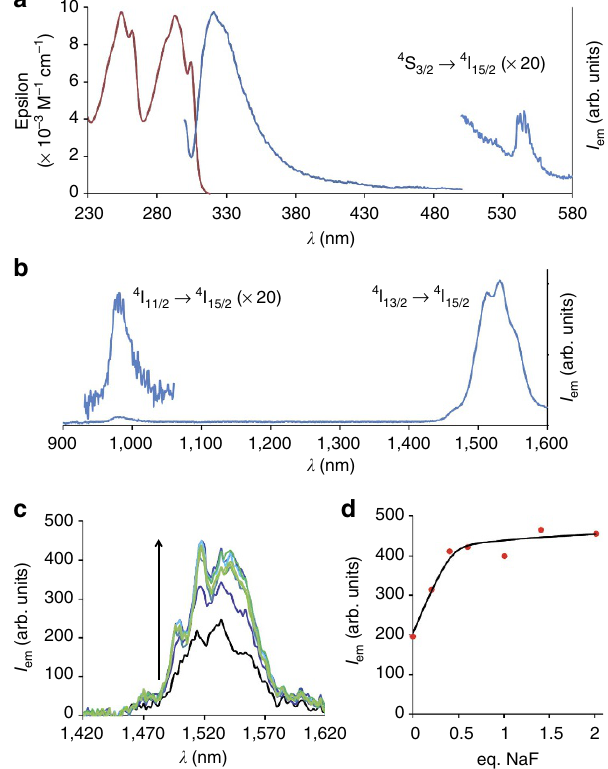
Figure 2 | Spectroscopic properties of the Er complexes. ( a ) The ultraviolet–visible absorption spectrum of the Er complex in D 2 O (red, c ¼ 270 m M) displayed strong p - p * absorption bands. When excited into these bands ( l exc ¼ 294nm), the emission spectrum of the complex displayed a ligand centred emission band in the visible region (blue), together with a contribution attributed to the 4 S 3/2 - 4 I 15/2 transition of Er (recorded at 0.5nm resolution). ( b ) Other Er centred transitions can be observed in the NIR region ( l exc ¼ 294nm, emission filter at 850nm, D 2 O). ( c ) The addition of fluoride anions into the D 2 O solution of the Er complex resulted in an increase of the Er emission and ( d ) the intensity of the signal at 1,540nm revealed a maximum increase for 0.5 equivalent (eq.) of fluoride anions, related to the formation of the dimeric [(ErL) 2 F] þ complex (the black curve corresponds to fitted data). NATURE COMMUNICATIONS|7:11978|DOI: